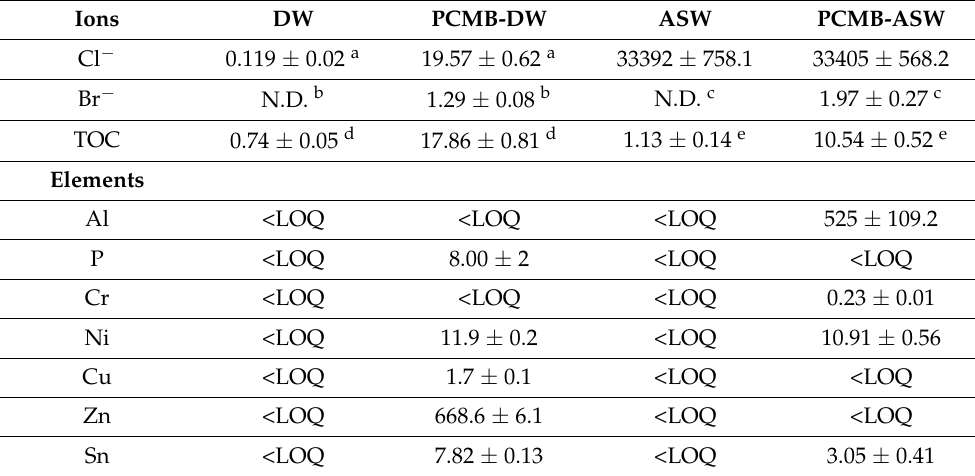
Table 1. Determination of ions, total organic carbon (TOC), and trace elements in DW and ASW in the presence or the absence of CPMB. Results (expressed as mg L − 1 in case of ions and TOC, and as µ g L − 1 in case of trace elements) are mean ± SD from 3 different measurements. Values that share the same letter differ from each other (Bonferroni, p <